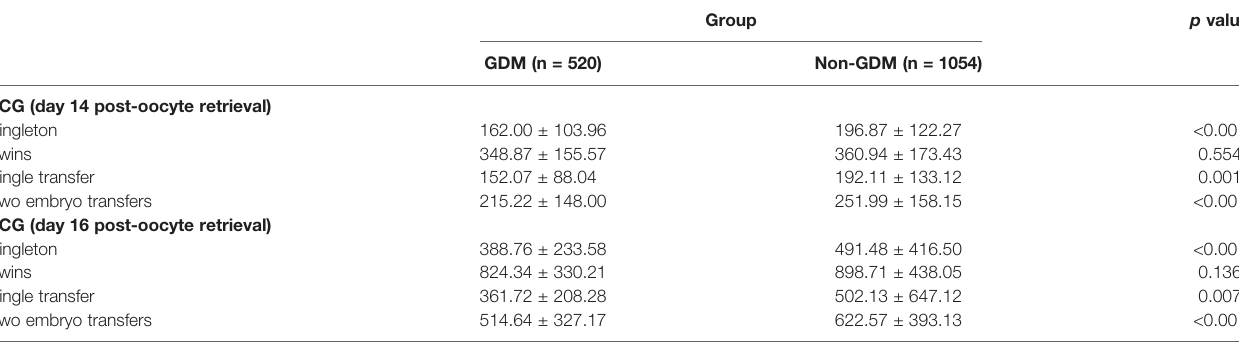
Data presented as mean ± SD unless otherwise indicated. hCG, human chorionic gonadotropin; GDM, gestational diabetes